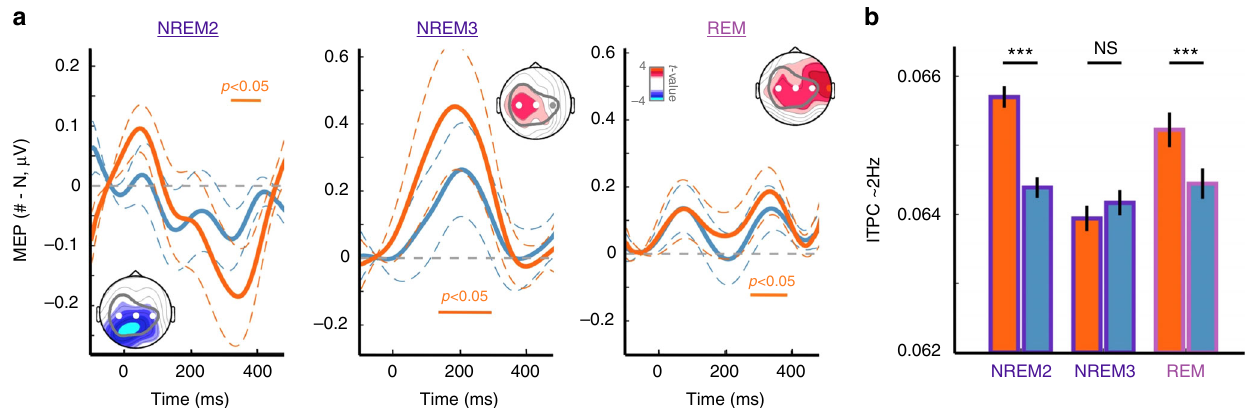
Fig. 4 Evoked activity to repeated noise snippets during sleep. a Target-locked memory-evoked potentials (MEPs) in NREM2 ( left ), NREM3 ( middle ), and REM ( right ) stages of sleep for RefRN ( orange ) or RN ( blue ) trials compared to N trials. Central electrodes were used ( circles on scalp topographies) and all targets but the fi rst one from a given trial were used (9 targets per trial). Note the resemblance between the NREM2 MEPs and the MEPs observed in wakefulness (Fig. 2b). Horizontal bars show signi fi cant clusters (NREM2: ([305, 405] ms; NREM3: ([130, 300] ms; REM: [280, 390] ms; P cluster < 0.05) for the RefRN vs. N difference ( orange ; no RN vs. N difference). Dotted lines denote the standard error of the mean across participants ( N = 20). Insets : scalp distribution of t -values (RefRN vs. N, paired t -tests) over temporal windows corresponding to the abovementioned clusters. The gray contour shows the scalp distribution of the MEPs observed in wakefulness (Fig. 2b). MEPs were temporally smoothed using a 50 ms-wide Gaussian kernel. b Inter-trial phase coherency (ITPC) extracted over the entire night recordings ( N = 20) on windows of 20 consecutive RefRN ( orange bars ) or RN ( blue bars ) trials. The corresponding windows were aggregated across participants (NREM2: N = 3698 and 3683; NREM3: N = 2480 and 2478; REM: N = 1190 and 1218 for RefRN and RN trials, respectively). ITPC was extracted around 2 Hz ([1.5, 3.5] Hz) and during stimulus presentation ([0.8, 5.5]s). Mixed-effects models revealed a signi fi cant interaction between sleep stages and stimulus condition (see Methods for details). Stars atop boxes indicate the results of post hoc statistical tests ( t -tests against 0, P < 0.001: ***; P < 0.01: **; P < 0.05: *, NS: P ≥ 0.05). Note the signi fi cant increase in ITPC for RefRN compared to